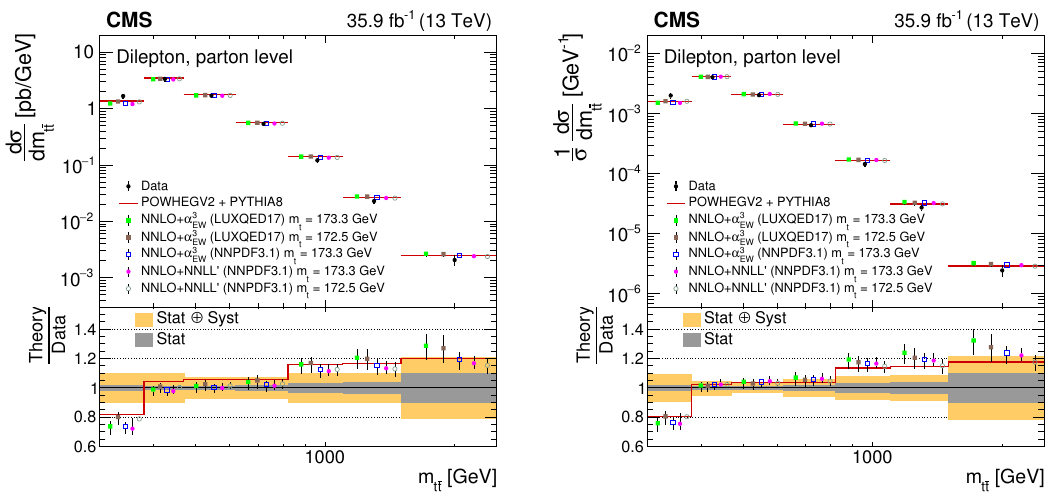
Figure 31 . The di(cid:11)erential tt production cross sections at the parton level in the full phase space as a function of m are shown for the data ((cid:12)lled circles), the theoretical predictions with beyond- tt NLO precision (other points) and the prediction from powheg + pythia (solid line). The vertical lines on the (cid:12)lled circles and other points indicate the total uncertainty in the data and theoretical predictions, respectively. The left and right plots correspond to absolute and normalised measure- ments, respectively. The lower panel in each plot shows the ratios of the theoretical predictions to the data. The dark and light bands show the relative statistical and total uncertainties in the data, respectively.